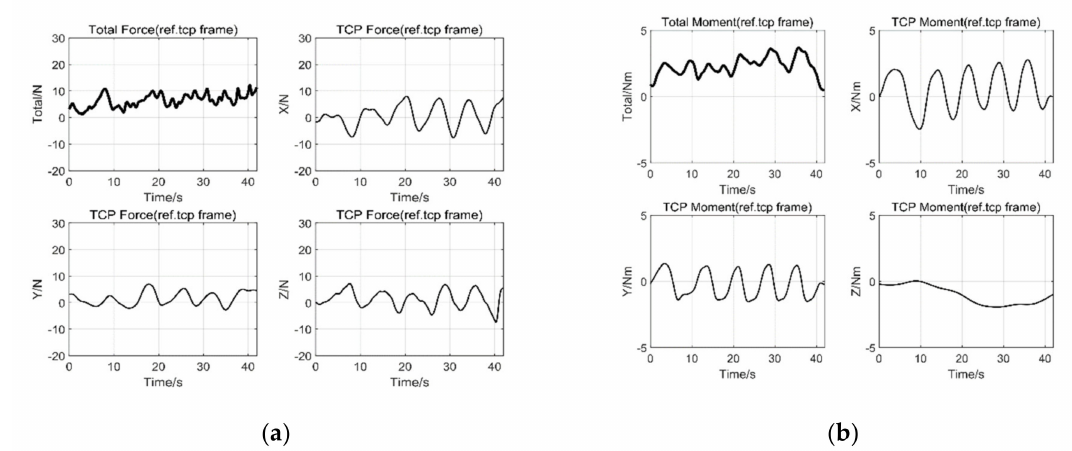
Figure 21. The interaction force and moment between the handle and the subject’s hand. ( a ) is the interaction force between the handle and subject’s hand; ( b ) is the moment between the handle and subject’s hand.